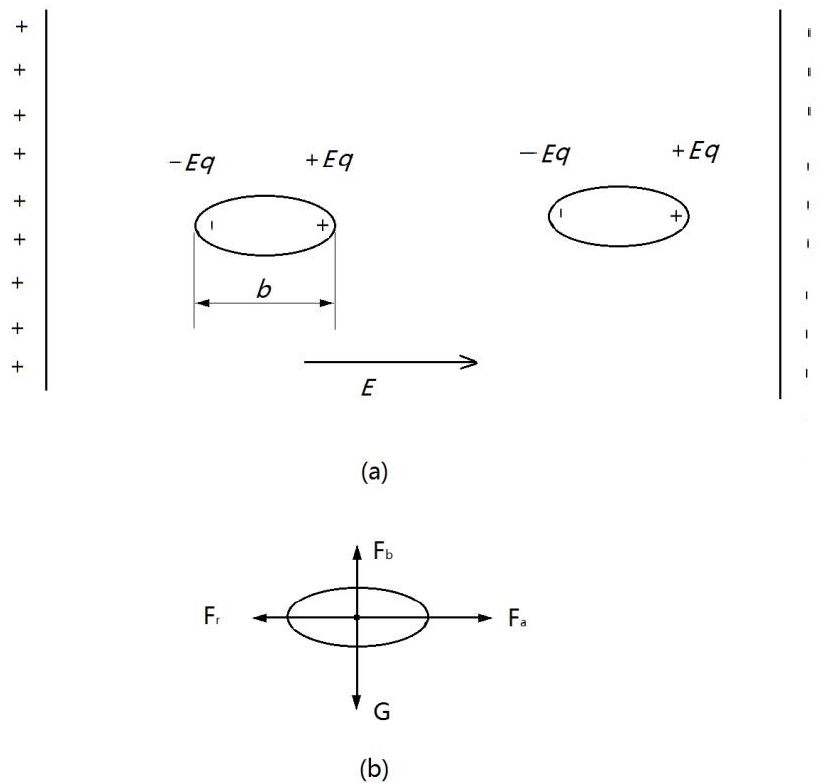
Figure 2. Force analysis for BNNSs under electric field immersed in ultrapure deionized water. ( a ) Global electric force; ( b ) forces imposed on a single BNNS.